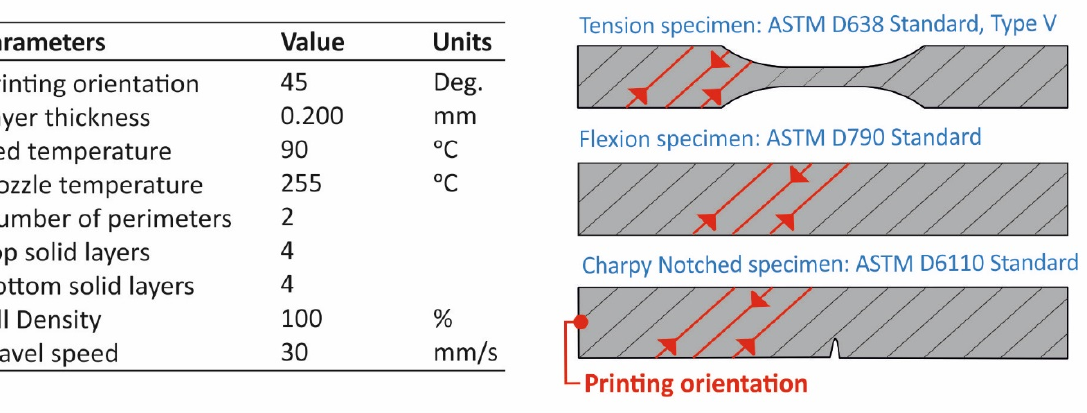
Figure 2. Settings employed in the additive manufacturing FFF 3D printing process for specimens’ fabrication in this work.